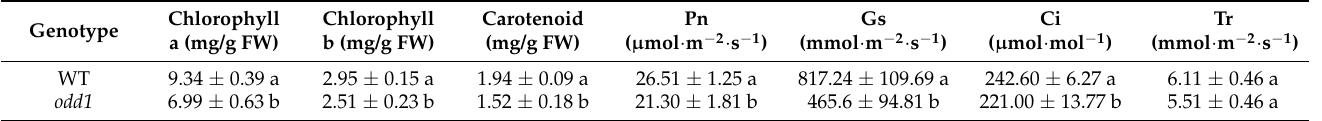
Figure 5. Phenotypic features of the root of odd1 . ( A ) The contrast of roots between WT ( left ) and Figure 5 odd1 ( right ) at 21 days after germination. ( B ) The quantification of root length in ( A ). Scale bars represent 1 cm. ‘*’ indicates very significant differences at p = 0.05 level. Vertical bars represent standard deviation (n = 10). Table 1. Photosynthetic parameters of WT and odd1 mutant at the fruit-setting